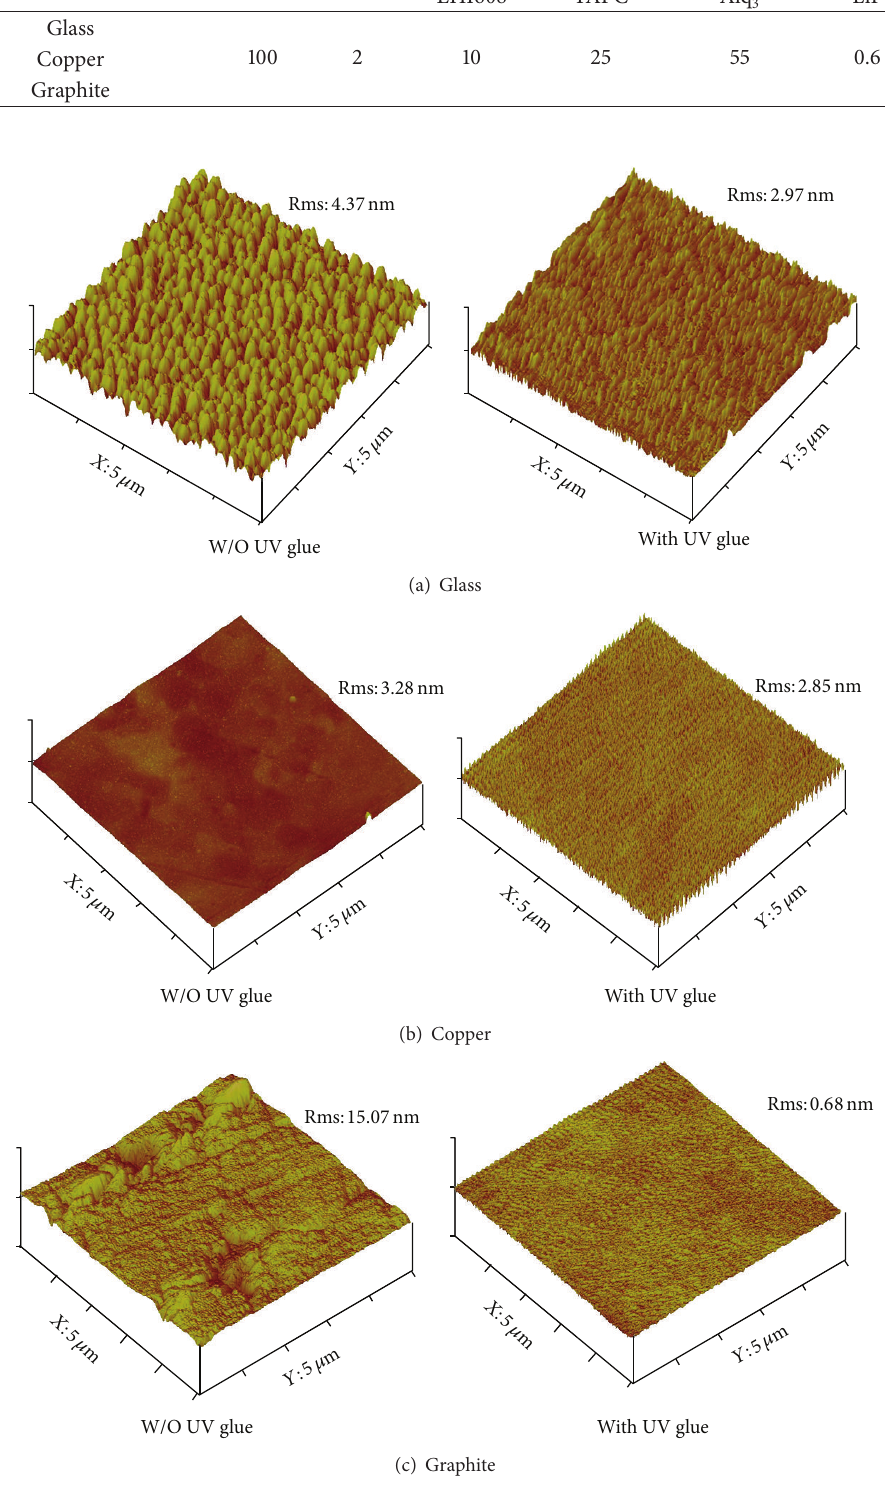
Figure 2: UV glue spin coated onto three substrates by